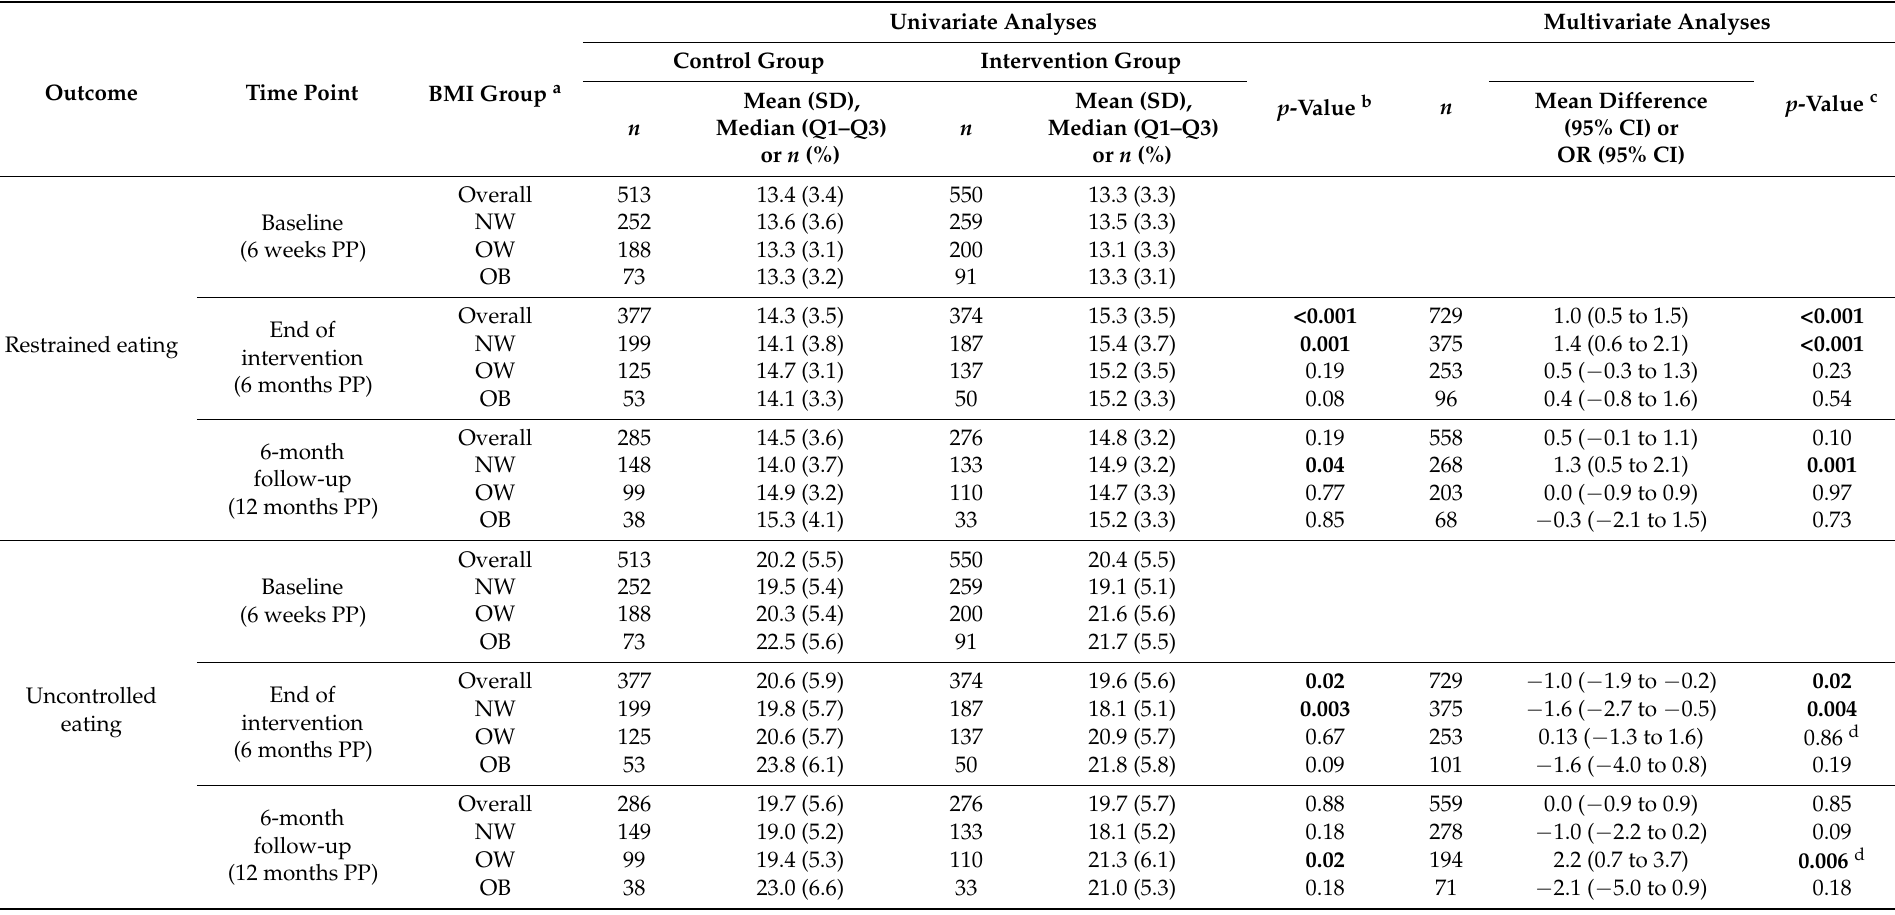
Table 2. Univariate and multivariate analyses of the effect of the INTER-ACT randomized controlled trial on lifestyle behaviors. Univariate Analyses Multivariate Analyses Control Group Intervention Outcome BMI Group a